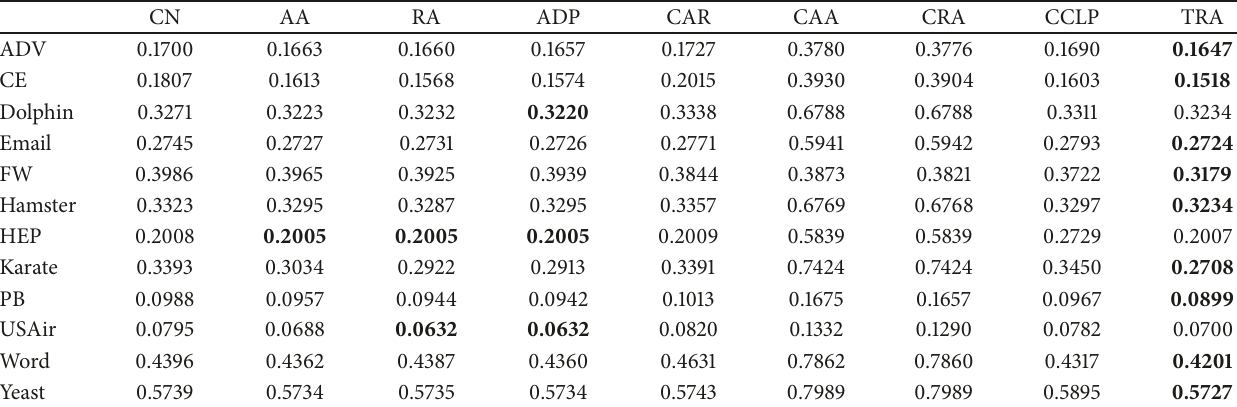
Table5:Therankingscoreofdifferentmethodsin12networks.Theresultsaretheaverageof50independentimplementationswith |𝐸 𝑡𝑠 |/|𝐸| = 0.1 . The best performance for each network is emphasized by